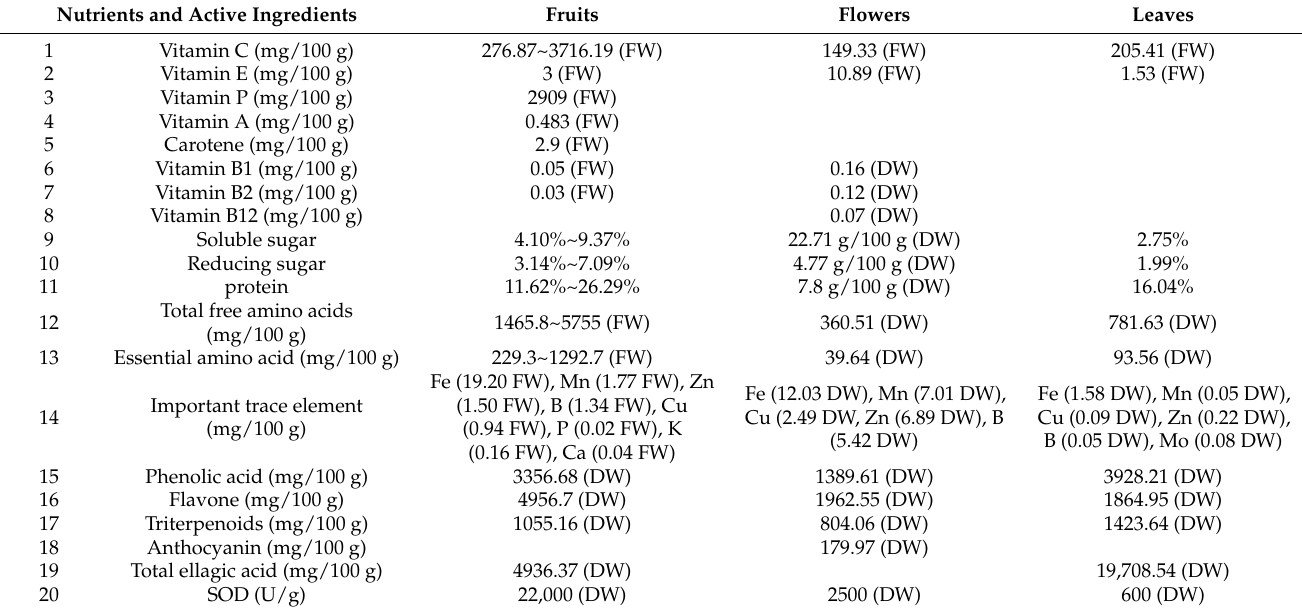
Table 1. Main nutrients and active components in different parts of R. roxburghii